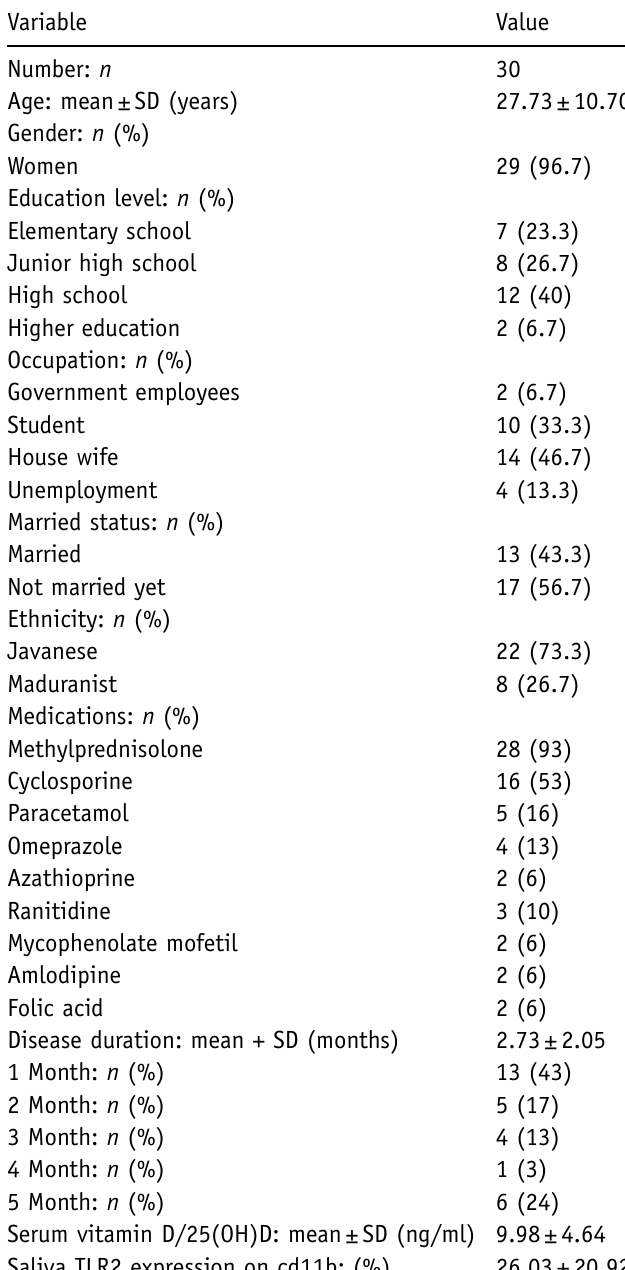
Table I. The characteristic of SLE